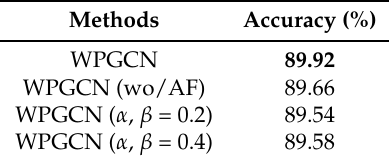
Table 3. Comparison of the recognition accuracy with or without adaptive fusion and replacement of common fusion. The best result is shown in bold.